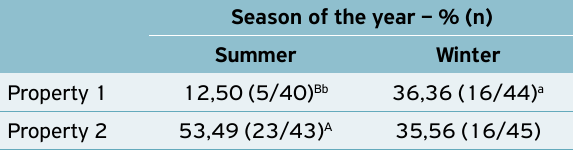
Figure 2. Tick infestation in perianal region in a horse from property Table 3. Distribution of tick infested animals in each property, in summer and winter, in Minas Gerais, Brazil.